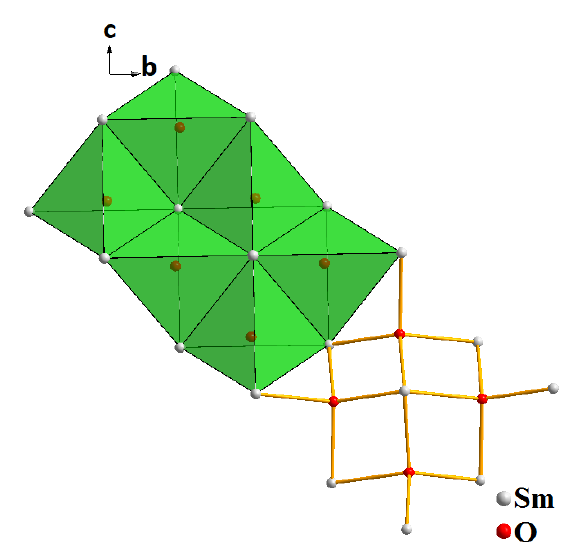
Figure 7. The cationic layers structure formed by the junction of tetrahedra [OSm 4 ].